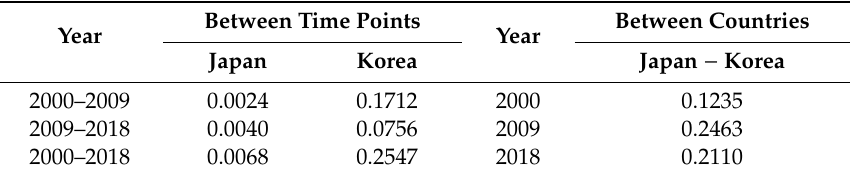
Table A2. Technological Distance between Japan and Korea over